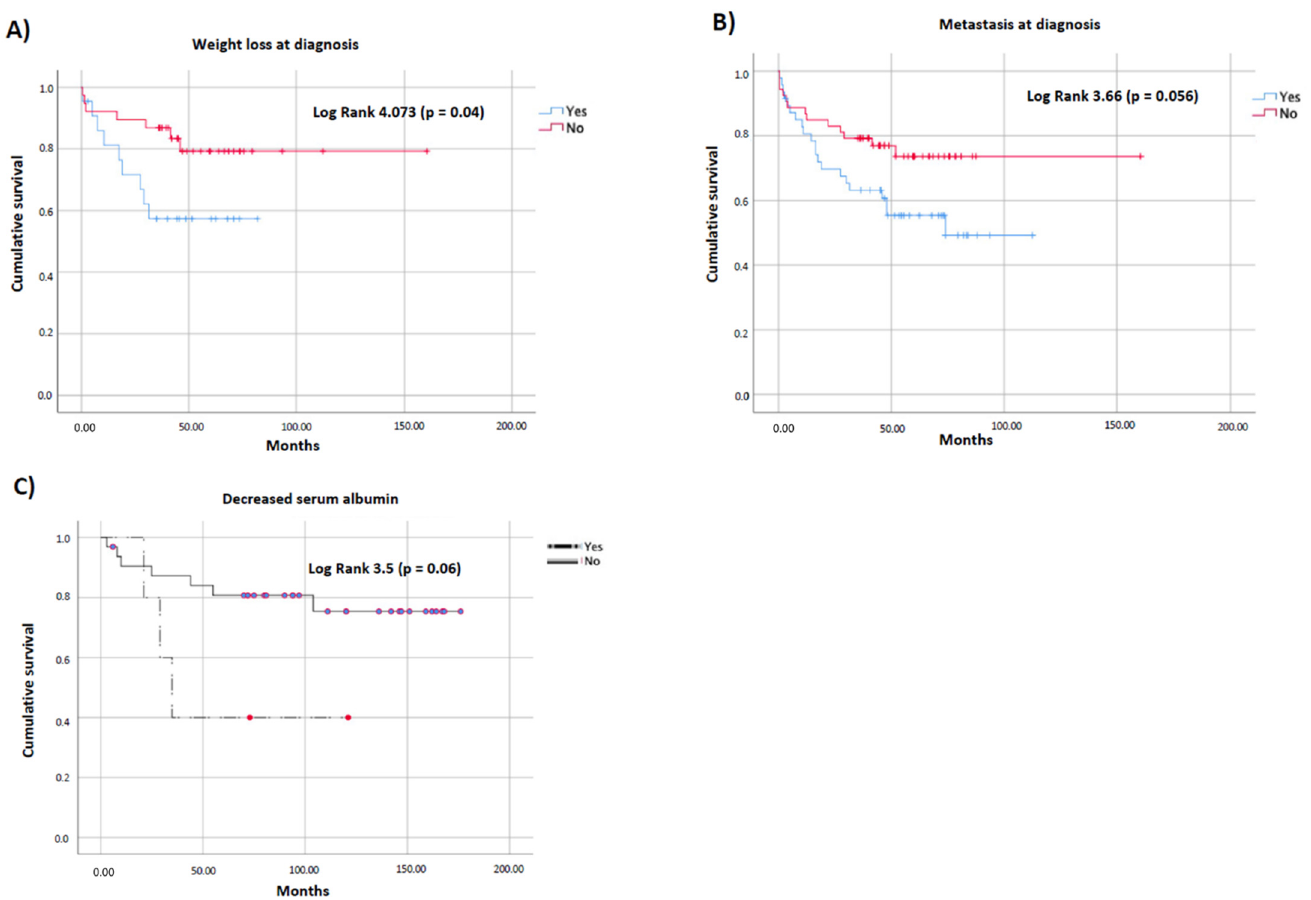
Figure 2. Cumulative survival curves for NEN patients according to the presence of nutrition-related parameters at diagnosis: ( A ) weight loss; ( B ) metastasis; ( C ) decreased serum albumin levels.